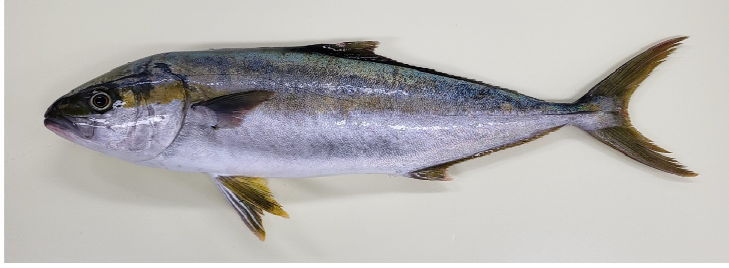
Figure 5. Yellowtail ( Seriola quinqueradiata ).